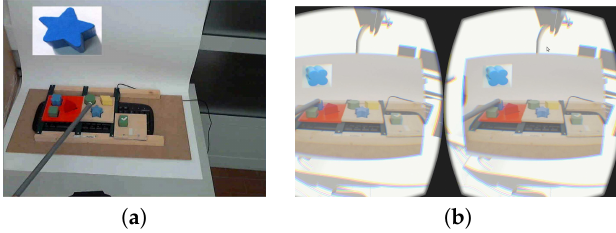
Figure 3. Task 1 setup used to compare performances. The user using a hand stick presses a sequence of key blocks defined by the computer at random. Interface view shows the next block to touch at the upper left corner of the display, after each correct touch. ( a ) Traditional interface vs. ( b ) immersive